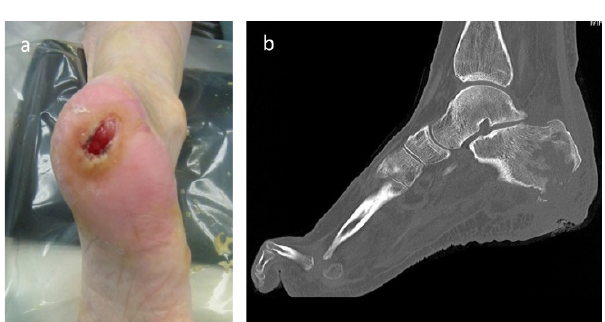
Figure 2. 2a : Plantar ulceration over calcaneal osteomyelitis in a patient with paraplegia after spinal cord injury. 2b: CT Scan showing the bone destruction deep to the